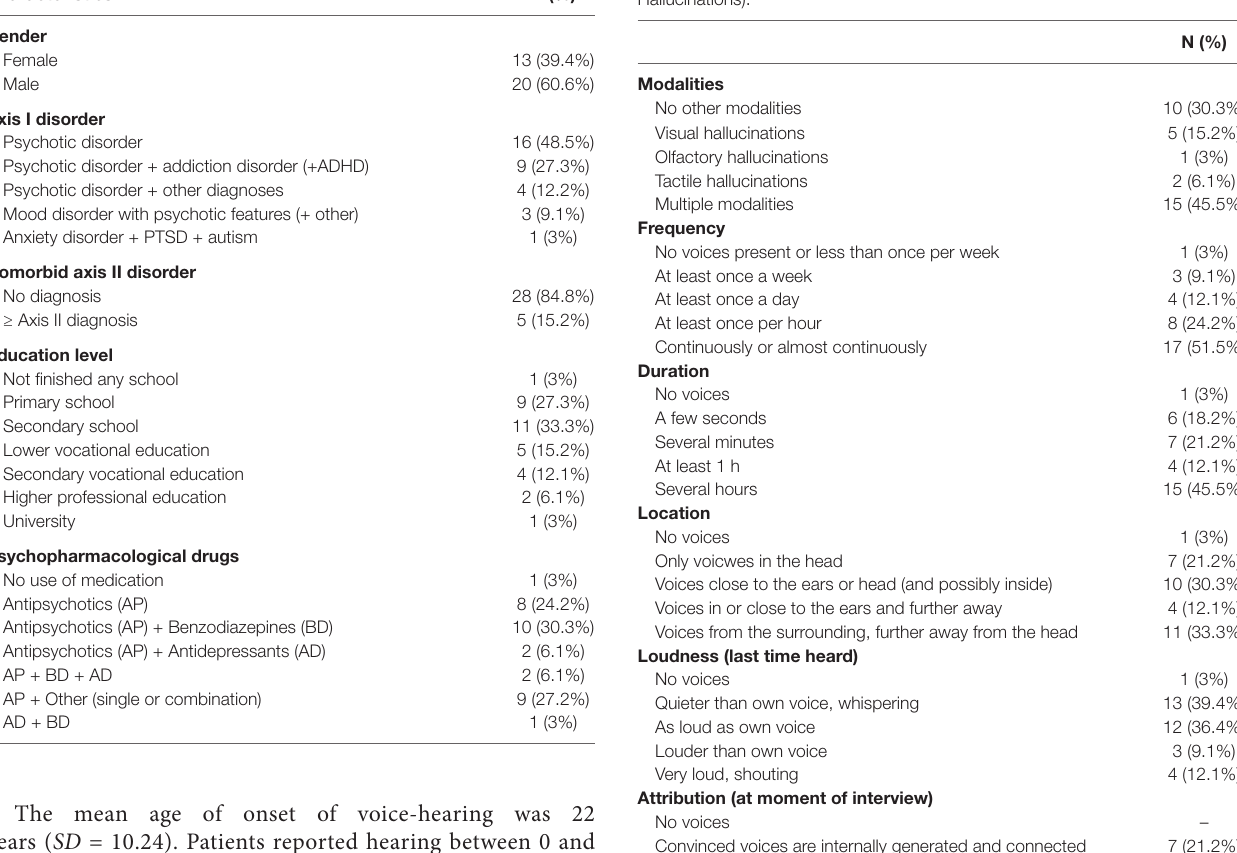
TABLE 1 | Patient characteristics ( N = 33). TABLE 2 | Characteristics of AHs last week measured with the PSYRATS-AH ( N = 33) (PSYRATS-AH, Psychotic Symptoms Rating Scale - Auditory